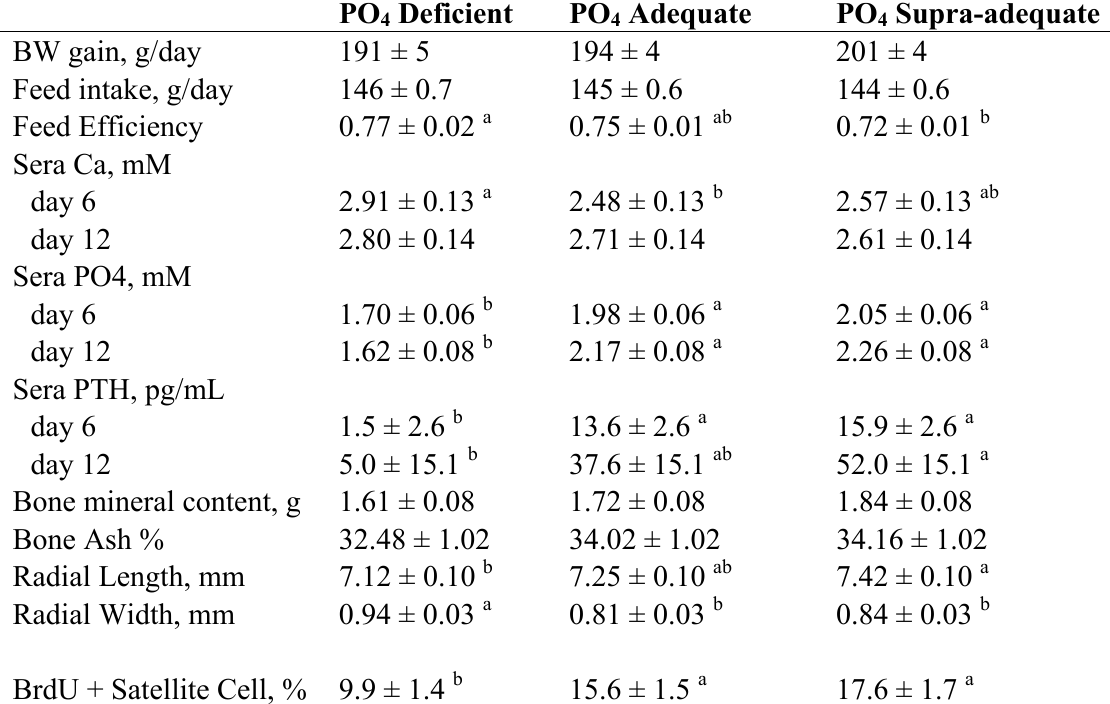
Table 3. Effect of dietary PO on growth parameters sera measurements in growing piglets 1 4